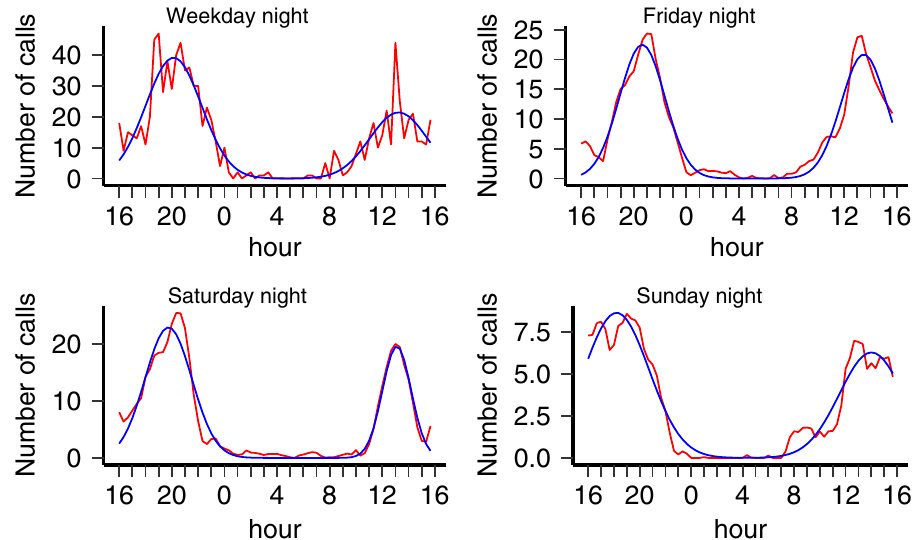
Figure 2. Aggregated calling activity of one individual for 4 different overnight periods. The calling activity as a function of the time of the day (red lines), for four different overnight periods: Weekdays (top-left), Fridays (top-right), Saturdays (bottom-left) and Sundays (bottom-right). Blue lines are smoothed Gaussian curves. For this individual, the minimum of activity typically occurs around 5:00 am.